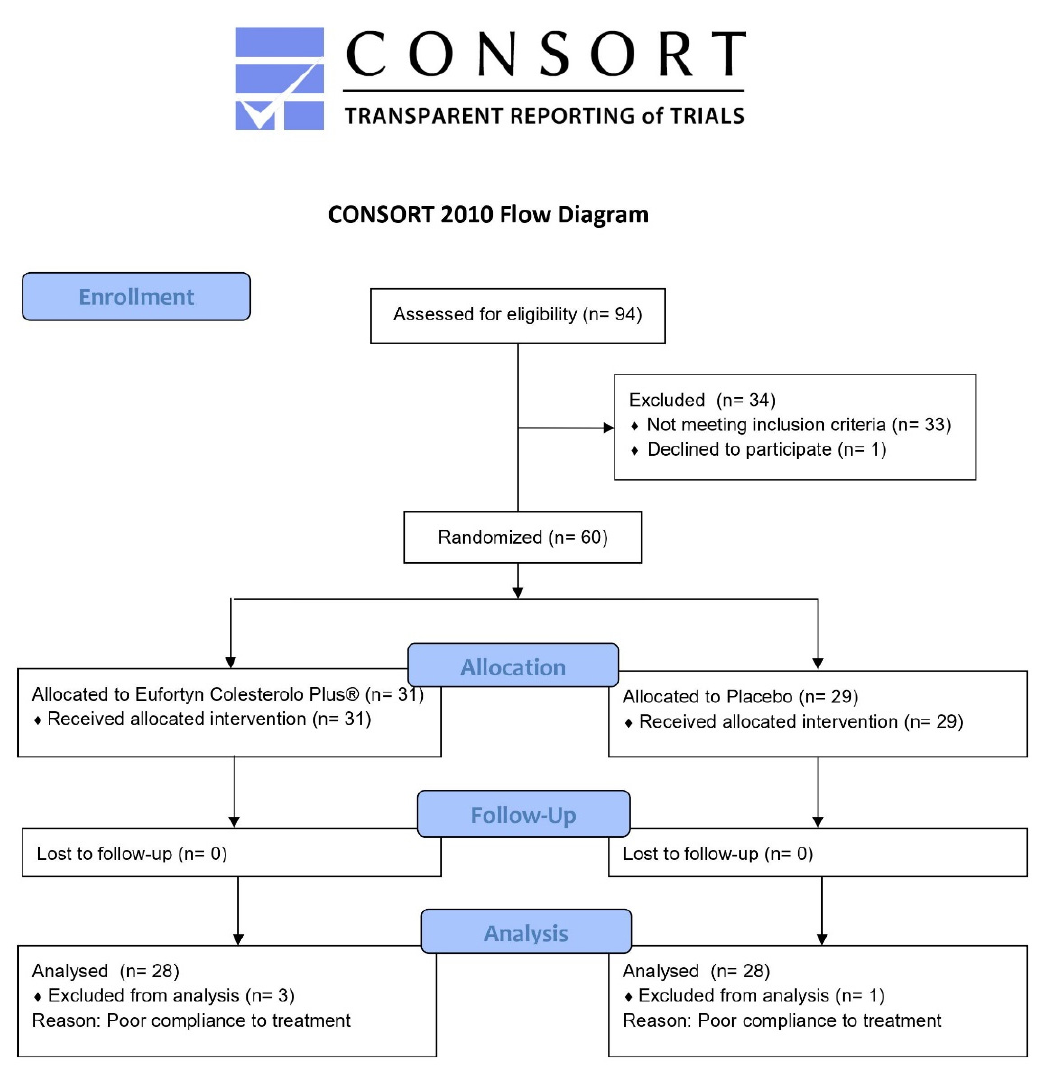
Figure 2. CONSORT flow diagram of the progress through the phases of the clinical study.